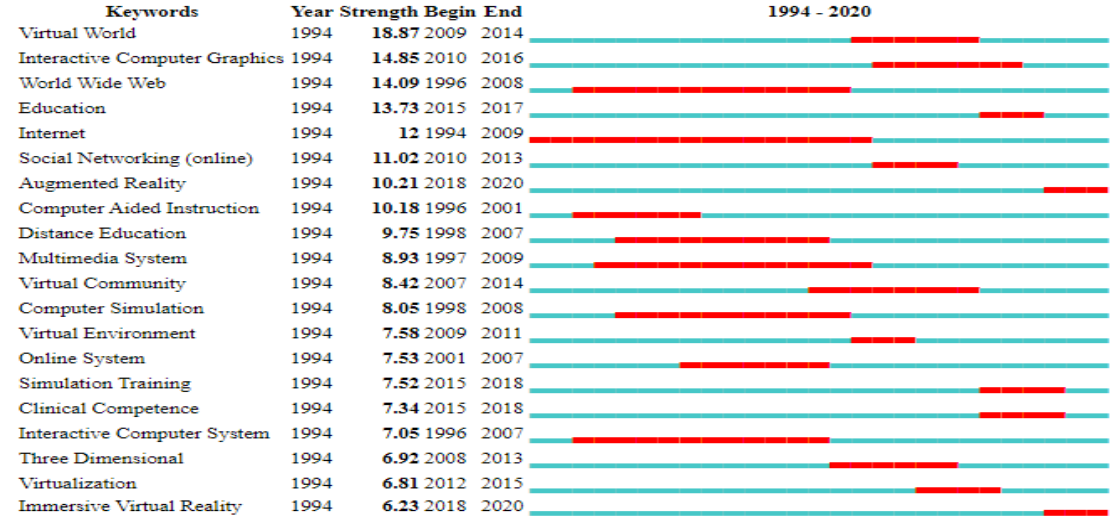
Figure 6. Top 20 keywords with the strongest citation burst.